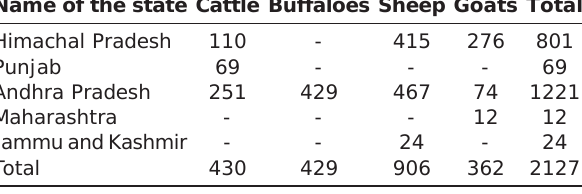
Table 1: Details of the samples collected from small and large ruminants Name of the state Cattle Buffaloes Sheep Goats Total Himachal